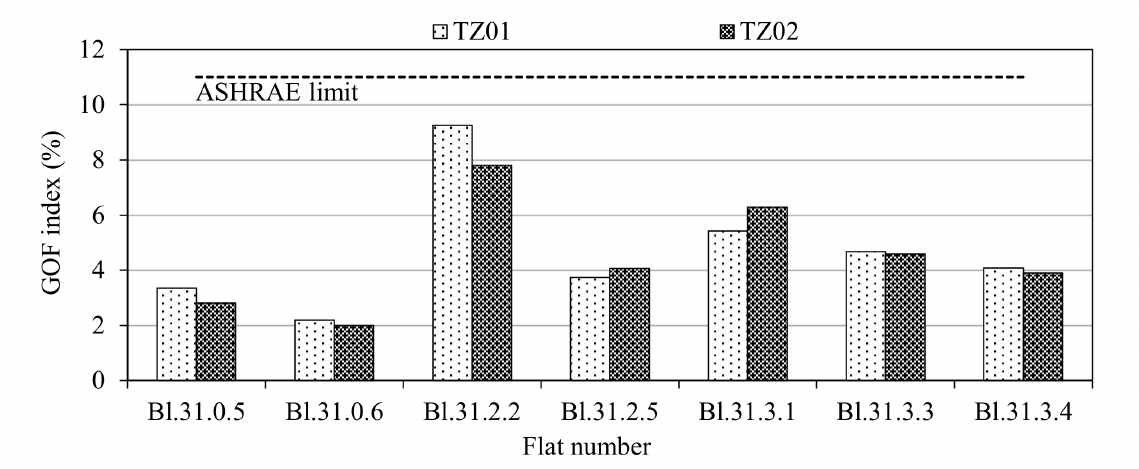
Figure 6. Calibration results of seven flats of the building. Adapted from [28].